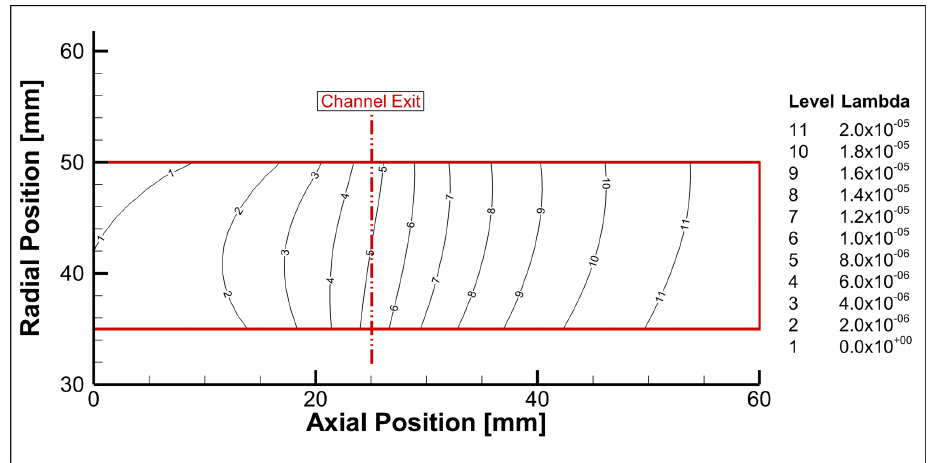
Figure 9. SPT-100 radial magnetic field intensity, along the channel centreline, as a function of axial position (z) compared to reconstructed data from Hofer et al. [17].